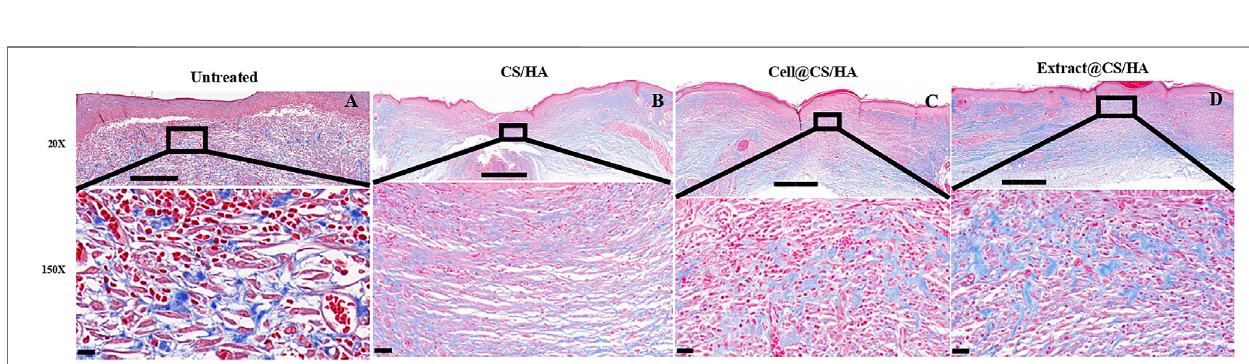
FIGURE3| RepresentativeH&E-stainedimagesofwoundsectionsandcomparisonofscarlengthamongwoundstreatedwithCS/HA,cell+CS/HA,andextract+ CS/HAat14 dayspost-wounding. (A) RepresentativeimagesofH&E-stainedwoundsections.Blackdouble-headedarrowsindicatetheedgesofscars.G:CS/HA;EC: extract + CS/HA; GC: cell + CS/HA. Scale bar (cid:1) 500 μ m. (B) Comparison of scar length after H&E staining. Wounds treated with extract + CS/HA had signi fi cantly narrower scar length than those treated with cell + CS/HA and CS/HA. Signi fi cant difference compared to CS/HA. * p < 0.05, ** p < 0.01. n (cid:1) 7 per group.